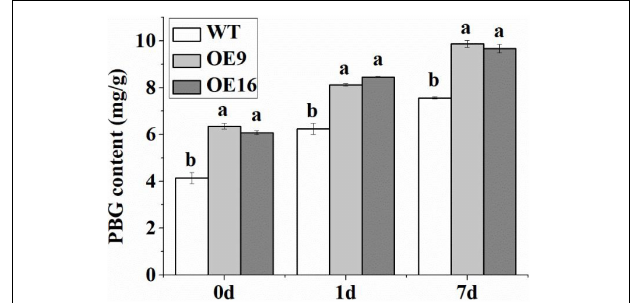
FIGURE 7 | The PBG content of the wild-type (WT) and transgenic plants in response to 4 o C treatment for 0, 1, and 7 day. OE: the CaALAD -overexpressing (OE) lines. The error bars represent the standard errors for three independent tests. Different letters show significant differences ( p < 0.05) based on Duncan’s